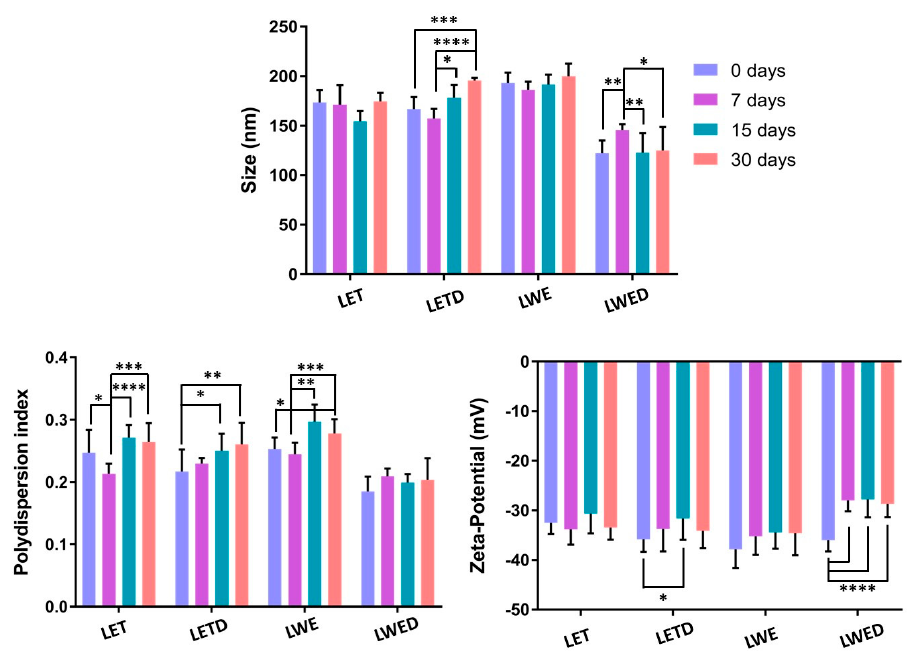
Figure 2. Evaluation of LNPs stability for 30 days for their size, polydisperse index, and zeta-potential. Statistical analysis was performed by ANOVA, followed by Sidak’s multiple comparison tests. Different asterisks indicate a statistical difference: p < 0.05 (*), p < 0.005 (**), p < 0.001 (***) and p < 0.0001 (****) Error bars represent the mean ± s.d (n = 9).